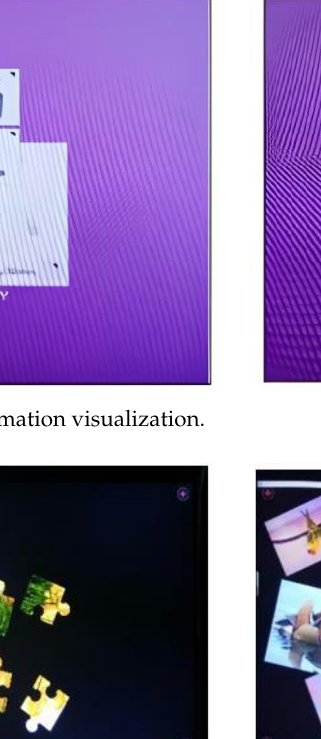
Figure 2. Scattered information visualization.